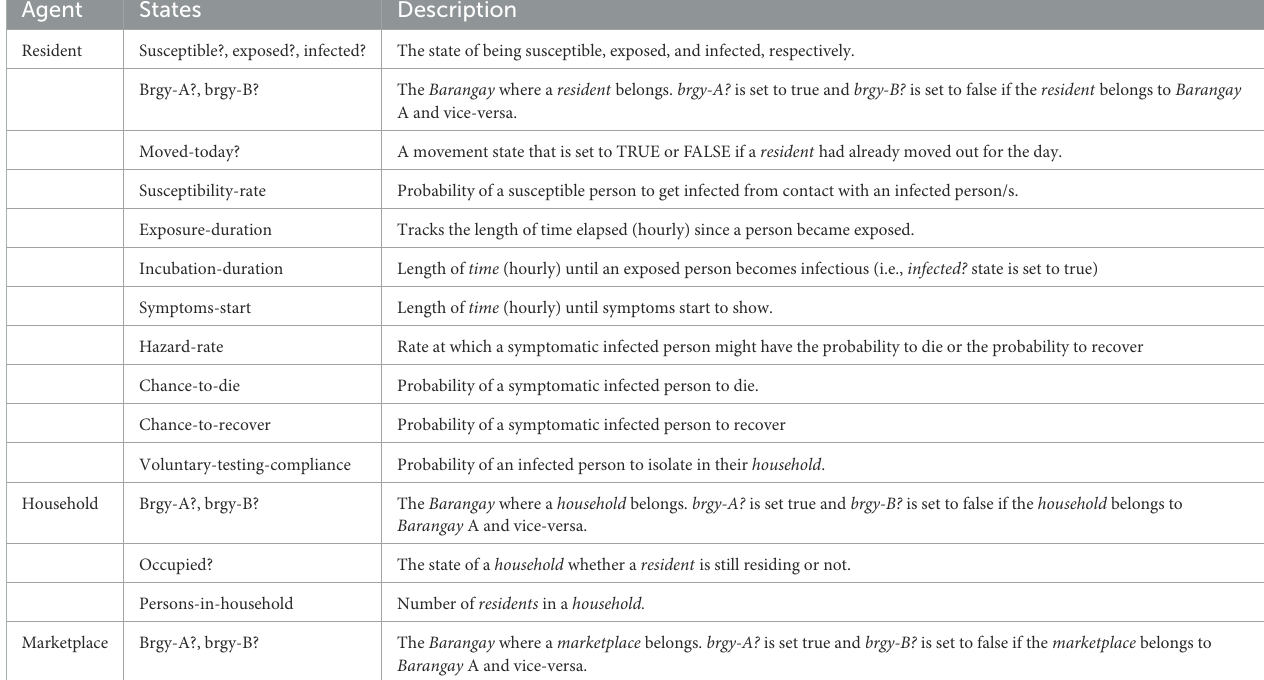
TABLE 2 Agent’s state and properties.